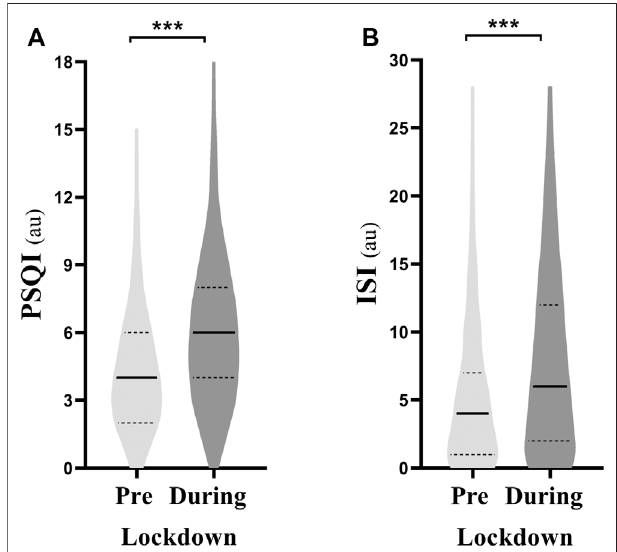
FIGURE1| Violinplotof (A) Pittsburghsleepqualityindex(PSQI)and (B) insomnia severity index (ISI) pre- and during-lockdown. *** means signi fi